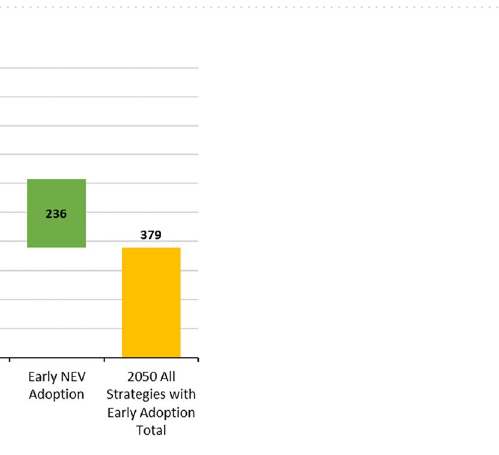
Figure 6. 2030 heavy-duty truck CO 2 emissions impact by short-term decarbonization strategy. Patterned bar denotes net increase in CO 2 from LNG fuel switch.